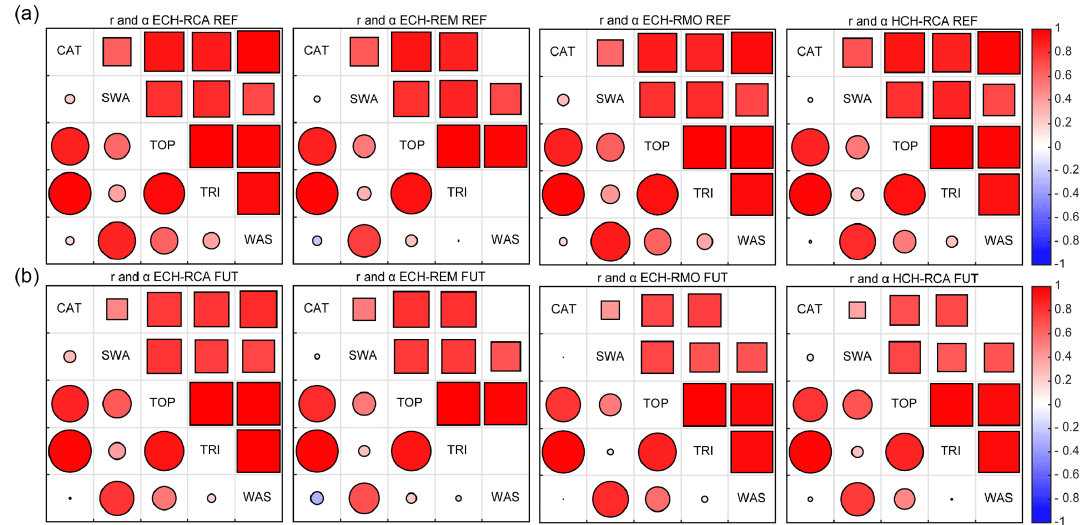
Figure 12. As Fig. 10, but for mean monthly actual evapotranspiration agreement between the five hydrologic models (CAT: CATHY, SWA: SWAT, TOP: TOPKAPI, TRI: tRIBS, WAS: WASIM) for the reference (REF, a ) and future (FUT, b ) periods.